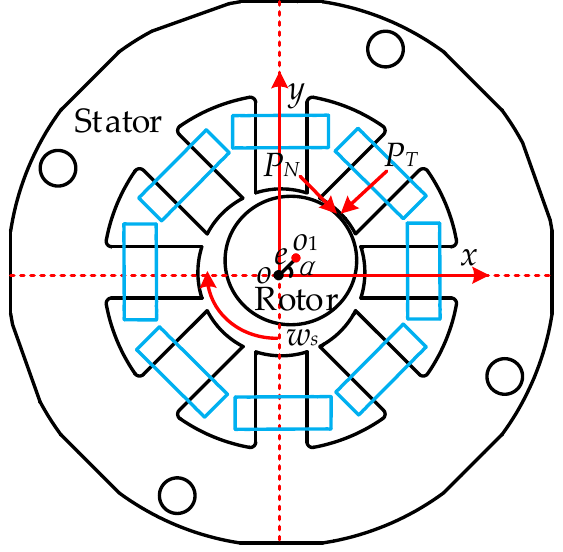
Figure 6. Clearance-Rubbing Model of MLDSB.